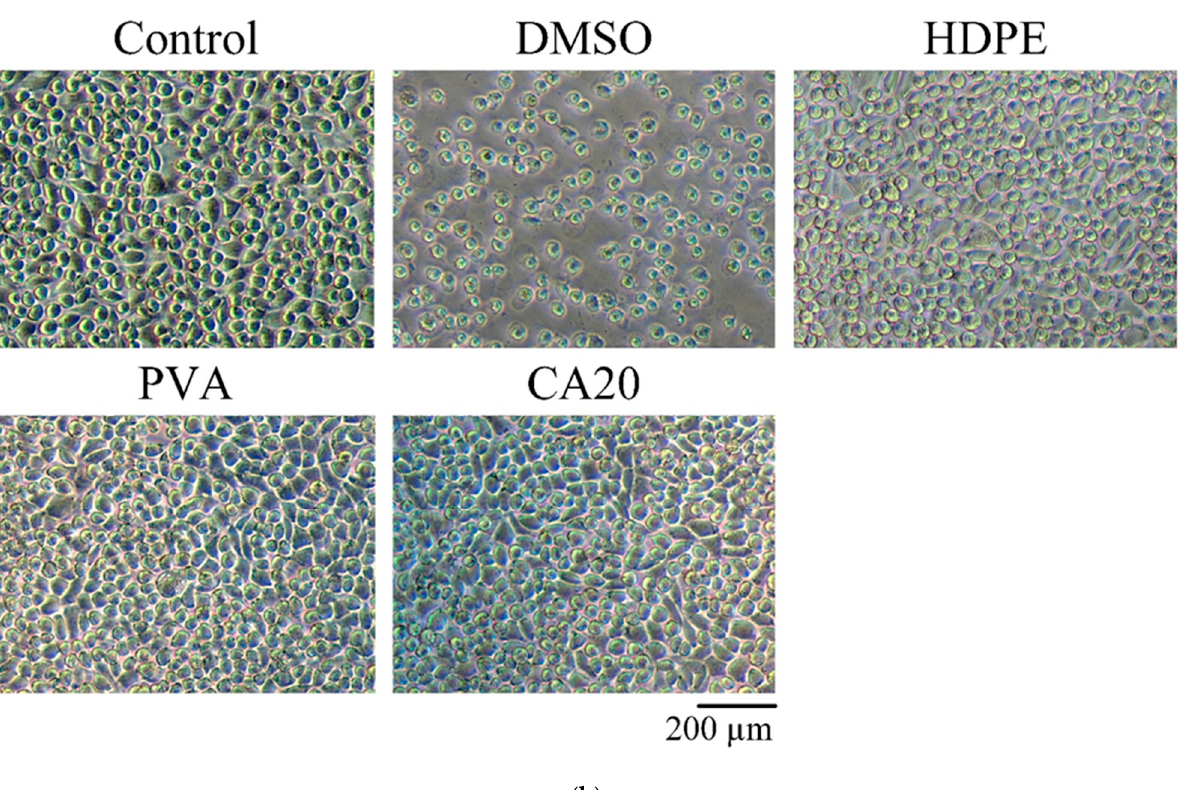
Figure 6. Cytotoxicity of L929 cells cultured in sample extracts according to ISO 10993-5 specification: ( a ) quantitative measurements ( n = 3), and ( b ) qualitative cell morphology observation.